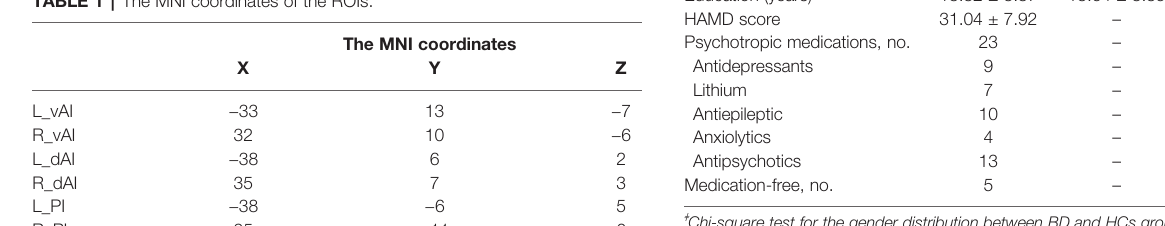
The detailed information was observed in Table 3 . These results